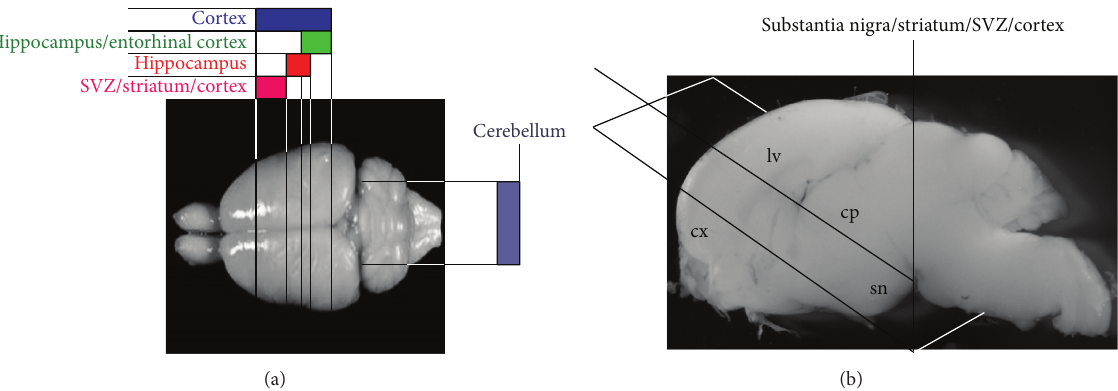
Figure 1: Different organotypic slices can be obtained from P2 to P7 postnatal forebrain or cerebellum by coronal sections of 350–400 𝜇 m (a). In (b), the brain sectioning to obtain 45 ∘ transversal sections of s. nigra/striatum/SVZ/cortex (sn, substantia nigra; cp, caudate putamen; lv, lateral ventricle; cx, cortex) used to model PD is